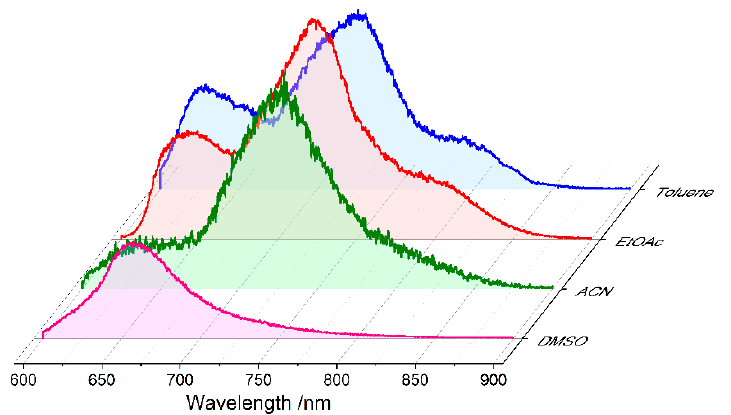
Figure 6. Dependence on the solvent polarity of the time-resolved emission spectra of PM650 recorded at 10 μ s delay time after laser photo-excitation at 532 nm in aerated solution at room temperature.